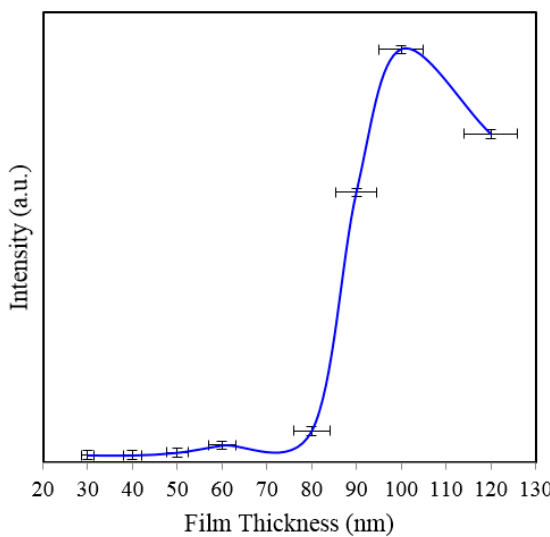
Figure 6. Peak SERS intensities measured at about 1361 cm − 1 measured from 8 × 10 − 5 M solution of Rh6G dye adsorbed on the surface of 30, 40, 50, 60, 80, 90, 100 and 120 nm gold films deposited on 80 nm NAAO nanoporous substrate with 3 s integration time.